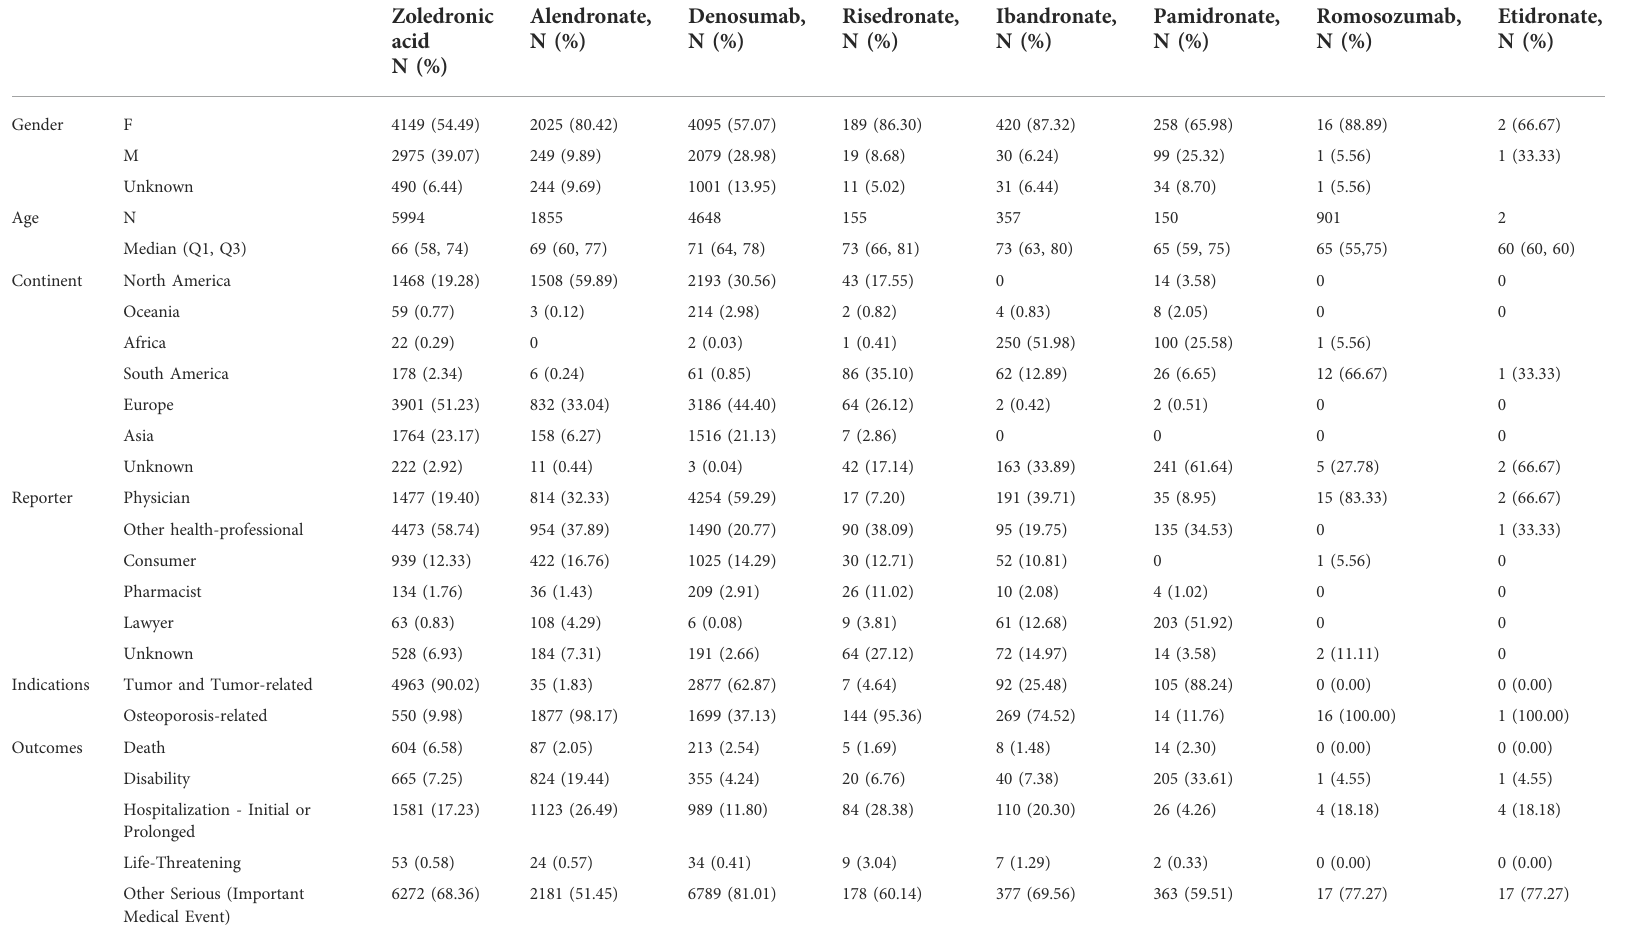
TABLE 2 Detailed information on antiresorptive-related osteonecrosis of jaw